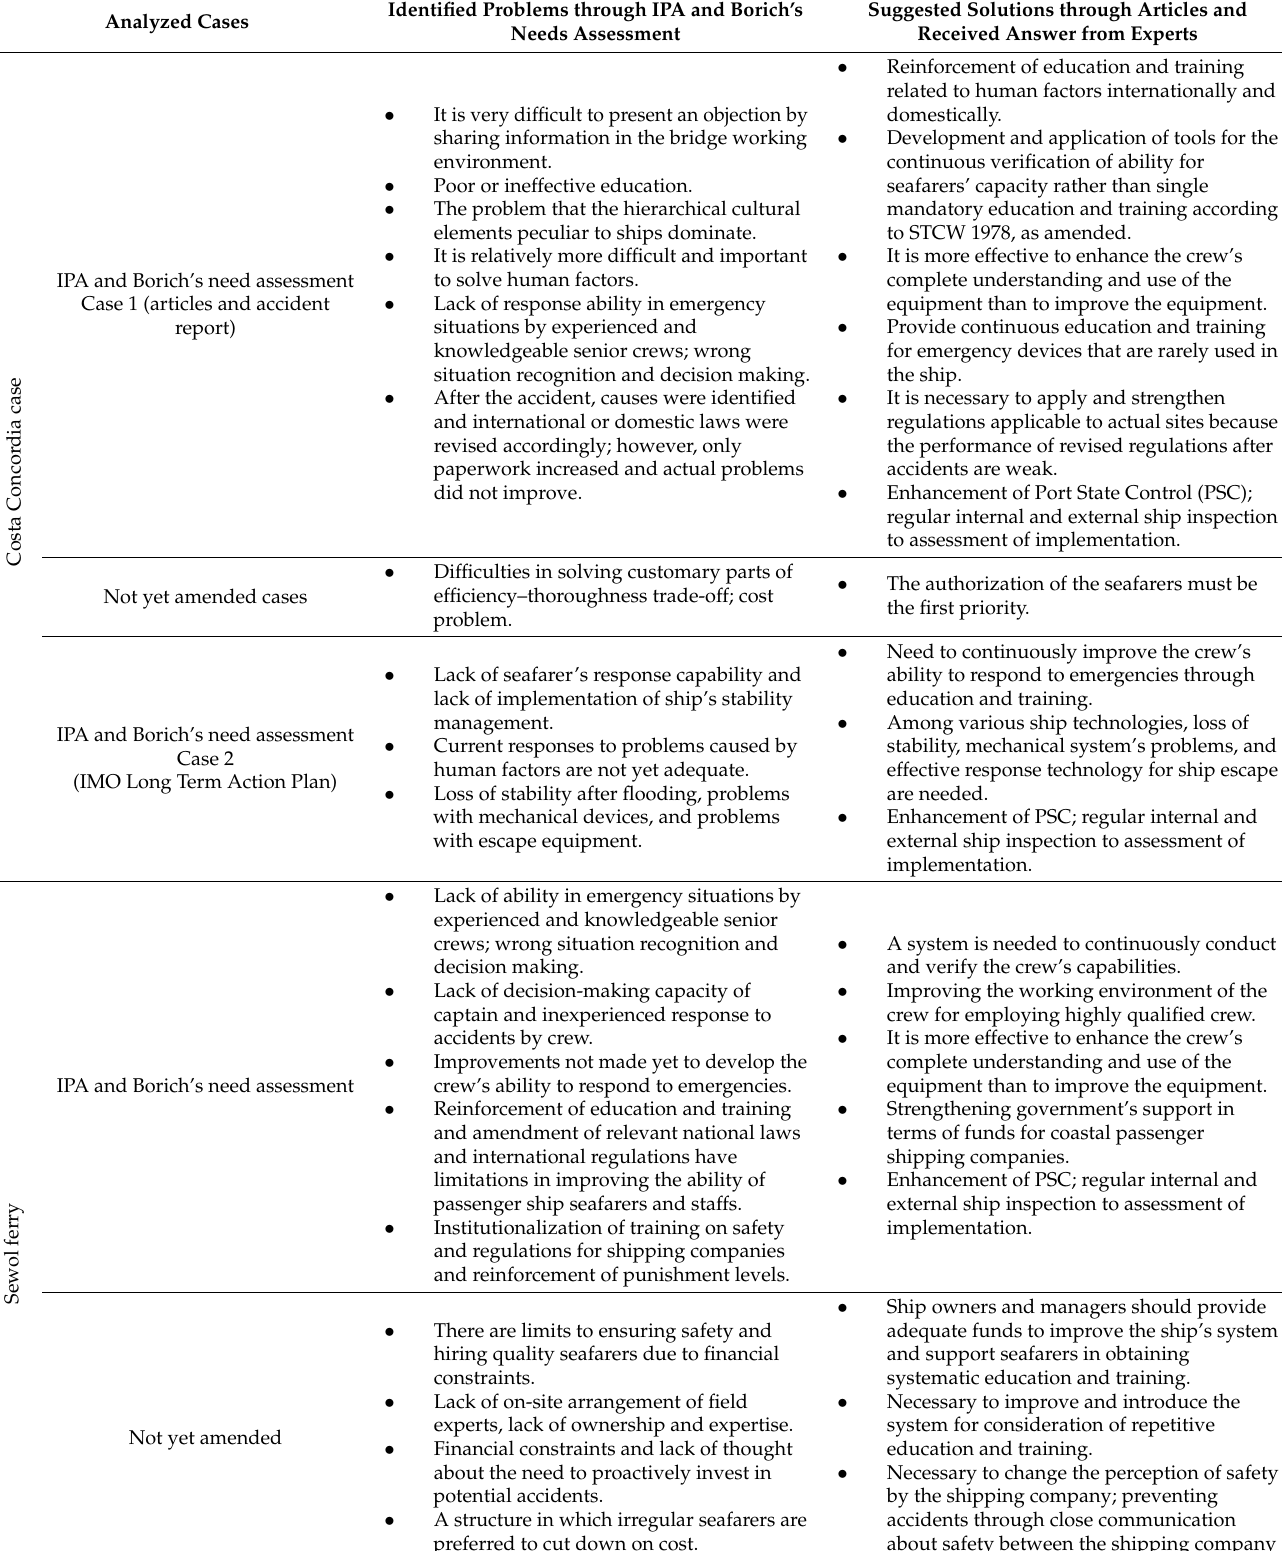
Table 9. Problems in the effective implementation of identified maritime accident causes and possible suggested solutions [65]. Analyzed